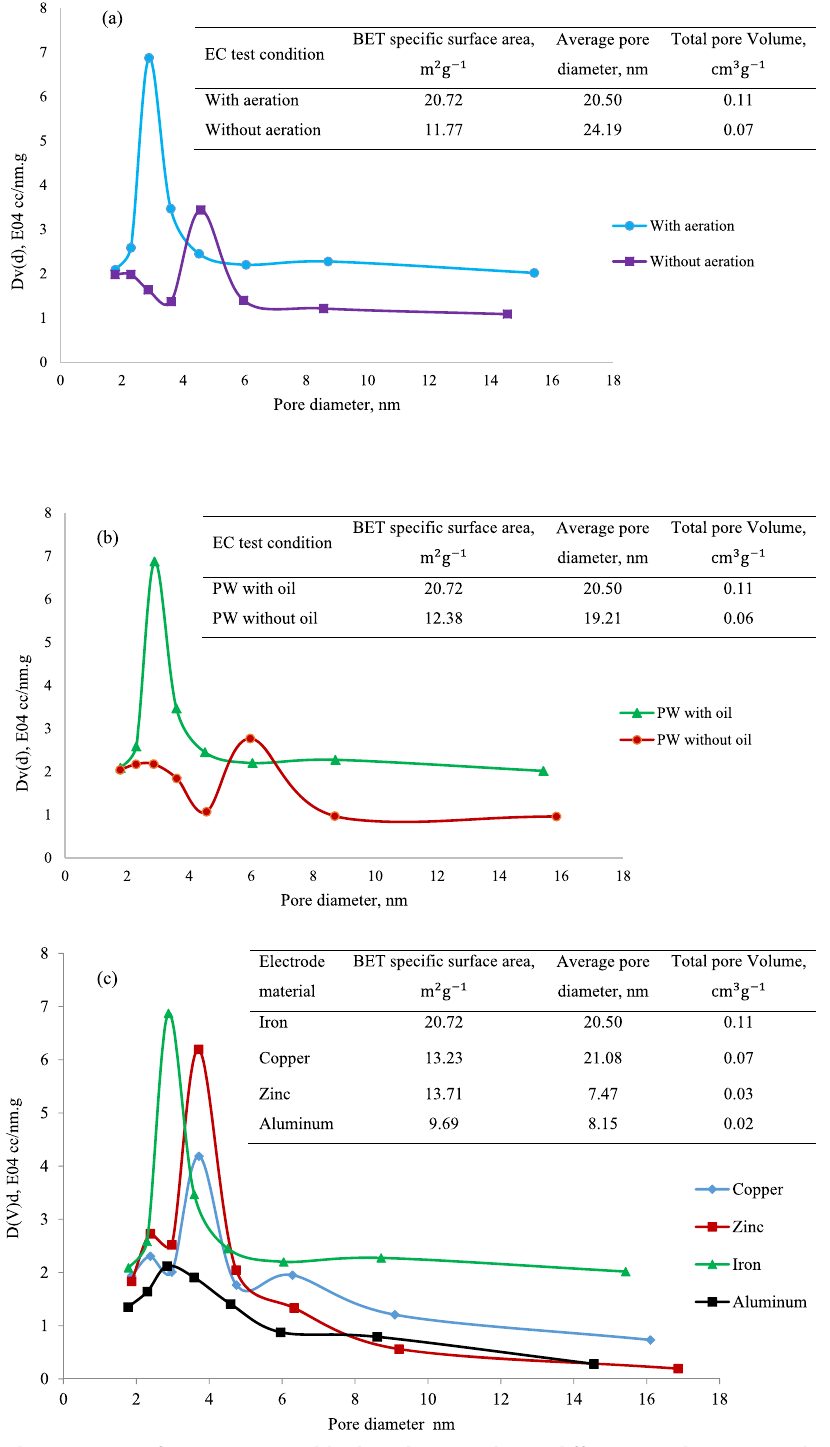
Table 2 encapsulates the results of conducting some EC experiments with different salt contents and demonstrates that the adsorption capacity decreased from 2.303 to 1.694 mg g − 1 with the increment of salinity from 2 to 43.5 g L − 1 . Meanwhile, the k 2 values rose from 0.058 to 0.188 g mg − 1 min − 1 . In addition, by